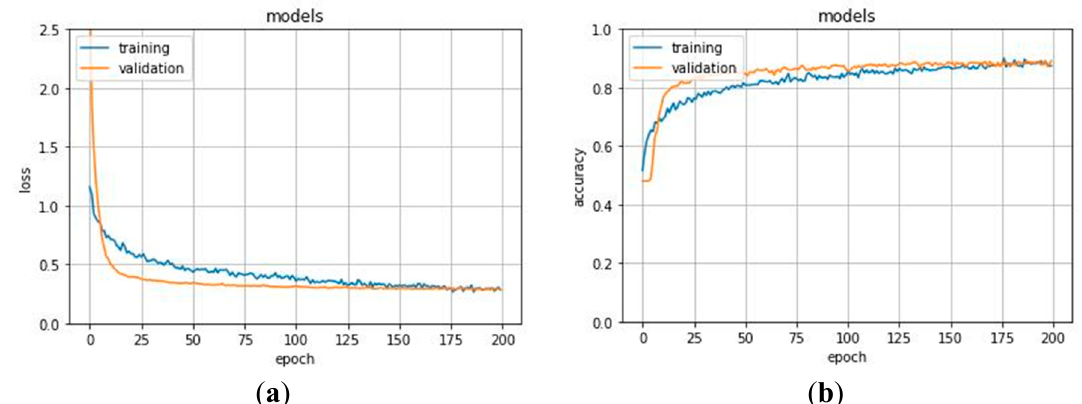
Figure 4. ( a ) Training and validation loss and ( b ) training and validation accuracy for the first experimentation. Accuracy metric is defined in Equation (1). Epoch is commonly referred to as the number of a full training pass over the entire dataset.